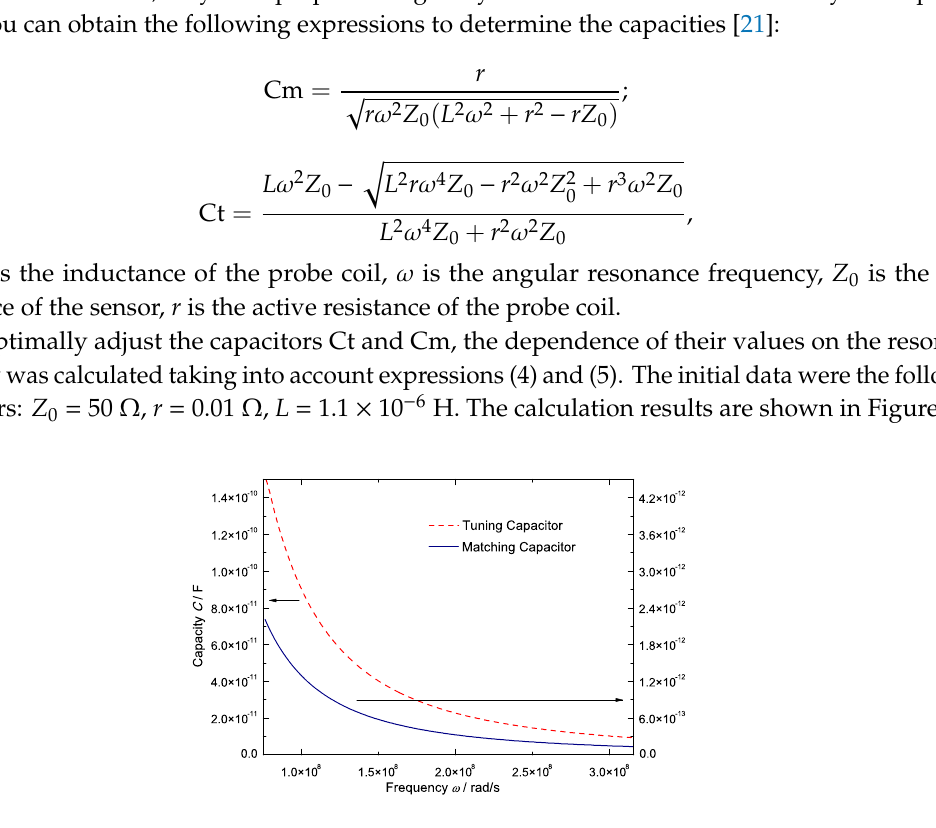
Figure 3. Dependence of nominal values of capacities Ct and Cm on resonance frequency.